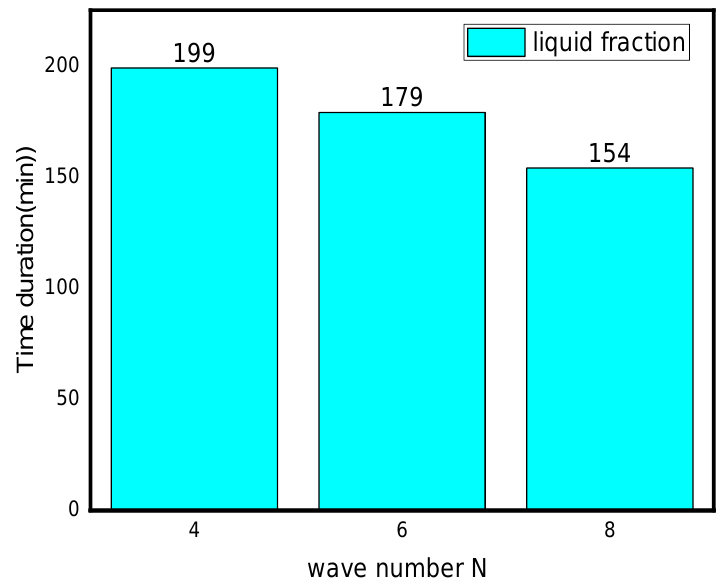
Figure 9. Time duration for different wave numbers.